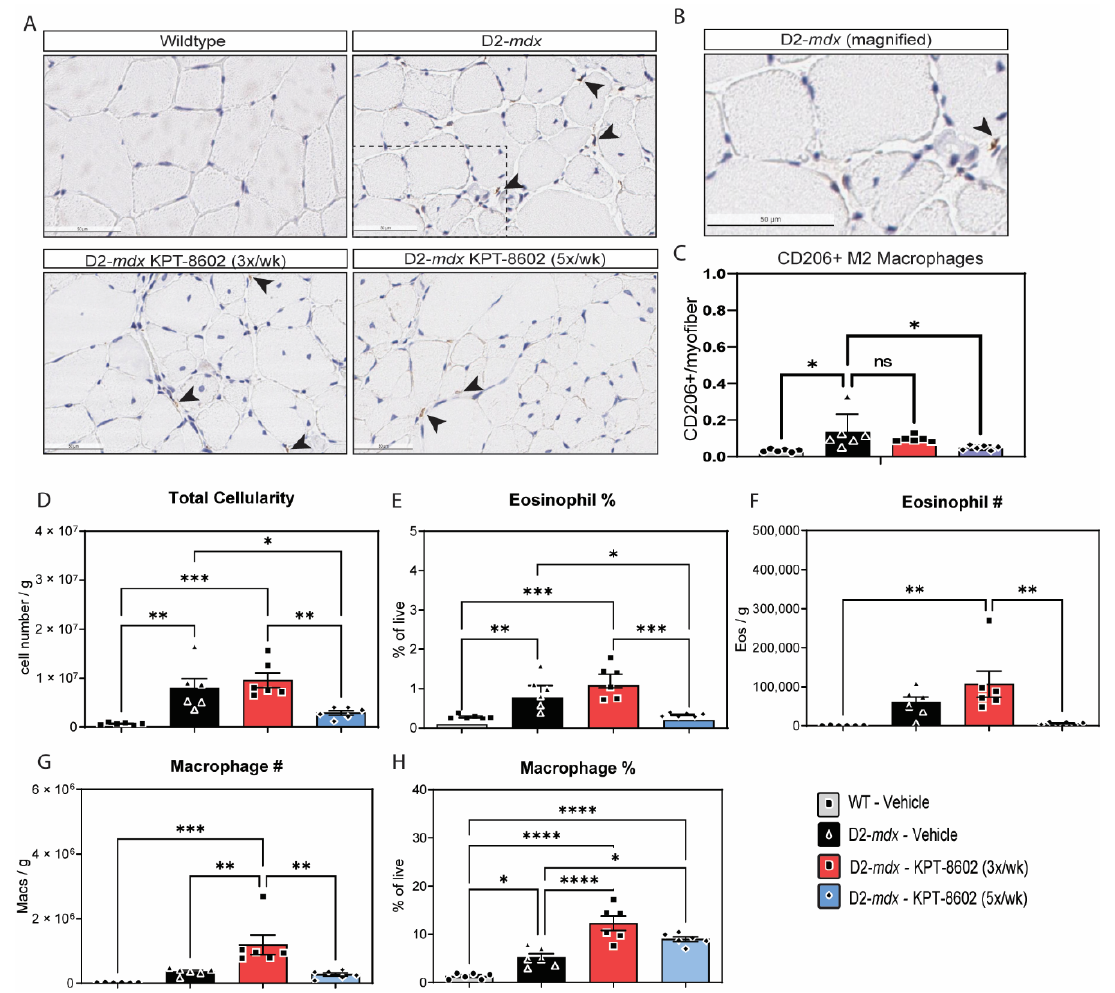
Figure 3. KPT − 8602 treatment shifts D2-mdx muscles to a pro-regenerative, M2 macrophage profile. ( A ) Immunostaining of CD206-positive TA muscles from WT-vehicle, D2- mdx vehicle, D2- mdx KPT − 8602 3x/week, and D2- mdx 5x/week experimental mouse cohorts. Arrows indicate CD206 stained macrophages. Boxed area magnified in B. Scale bar = 50 µm; ( B ) Magnified inset of a CD206+ macrophage from the D2- mdx sample; ( C ) Quantification of the total number of CD206+ M2 macrophages normalized to the total number of myofibers per area quantified to a minimum of 500 myofibers. All data is presented as mean ± SEM, n = 6; * p < 0.05, ** p < 0.01, *** p < 0.001, **** p < 0.0001; one-way ANOVA with Tukey’s HSD test); ( D ) Total cellularity measured in quadricep muscle cell preparations from the 4 experimental cohorts: WT vehicle (grey), D2- mdx vehicle (black), D2- mdx 3x/week (red); D2- mdx 5x/week (blue); ( E , F ) graphs showing the percentage of eosinophils and the total eosinophil number/gram muscle wet weight; ( G , H ) Graphs showing the percentage of macrophages and the total macrophage number/gram muscle wet